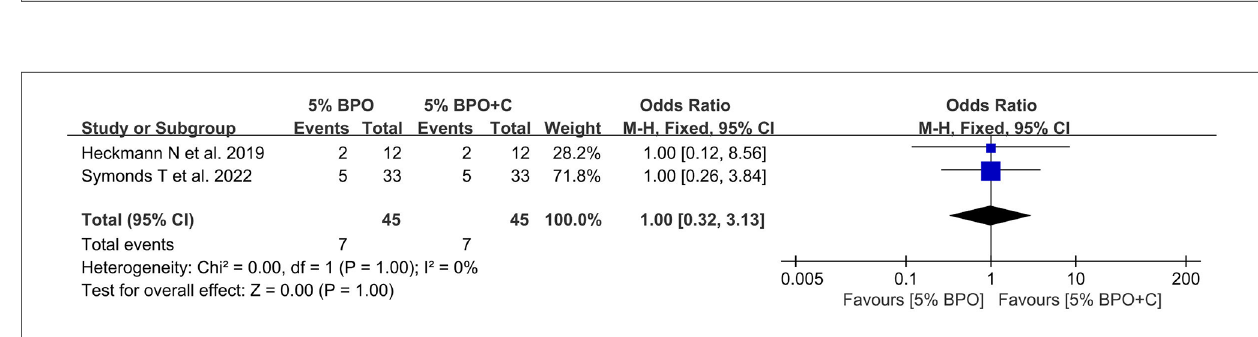
FIGURE 5 Forest plot showing the rate of positivity for Cutibacterium acnes with 5% benzoyl peroxide vs. 5% benzoyl peroxide with